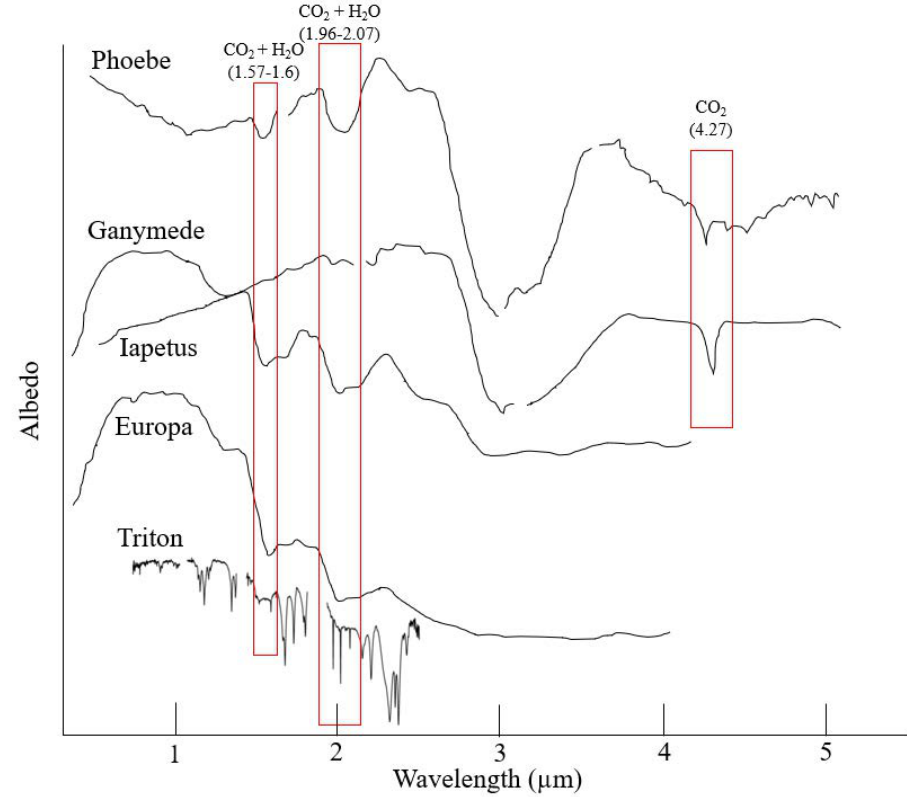
Figure 1. Infrared spectra of the Jovian, Saturnian, and Triton moons with labeled CO 2 (1.65, ~2.0, 4.27 µ m) spectral bands. Note that the 4.27 µ m band of Iapetus is shifted in comparison with the Phoebe spectrum. Spectra offset for clarity. Europa and Ganymede spectra from [8]; Iapetus spectrum from [9]; Phoebe spectrum from [10]; Triton spectrum from